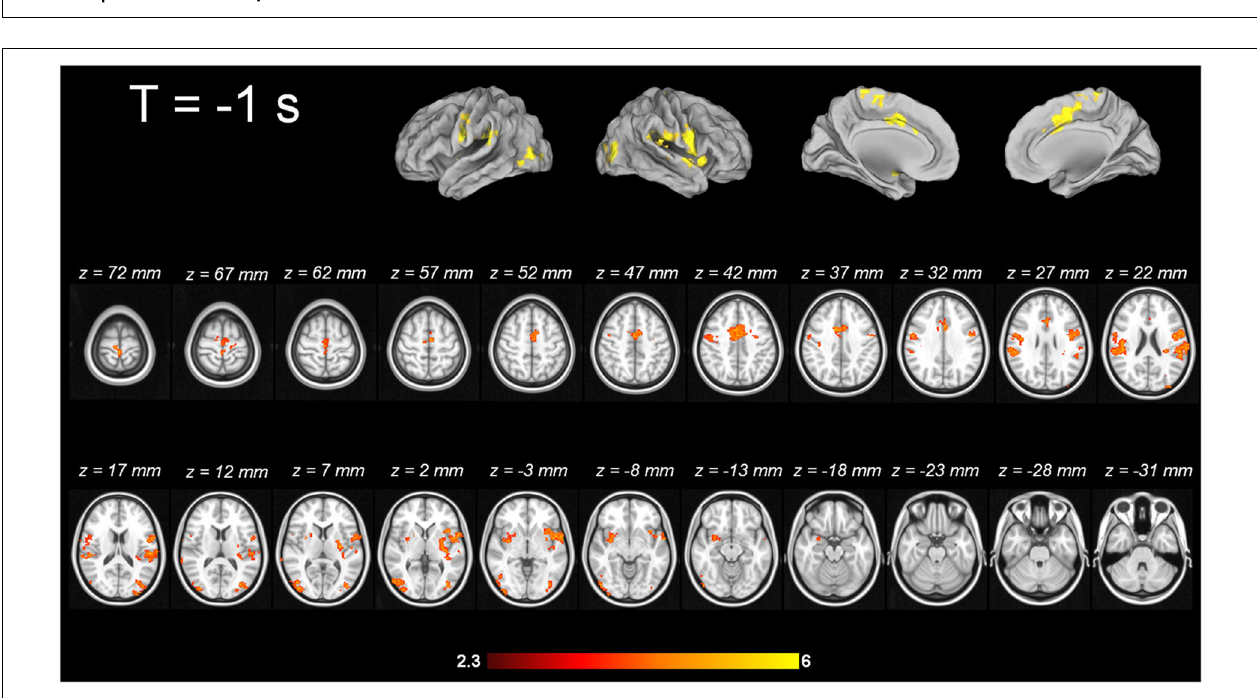
RSN/BOLD-signal and YGTSS were r = 0 . 53 ( p = 0 . 031, FDR- corrected for multiple comparisons) for RSN 4 at coordinates x = 2, y = − 14, z = 64 (MNI space) and r = 0 . 42 ( p = 0 . 04, FDR-corrected) at coordinates x = 2, y = − 20, z = 64 (MNI space) for RSN 7,